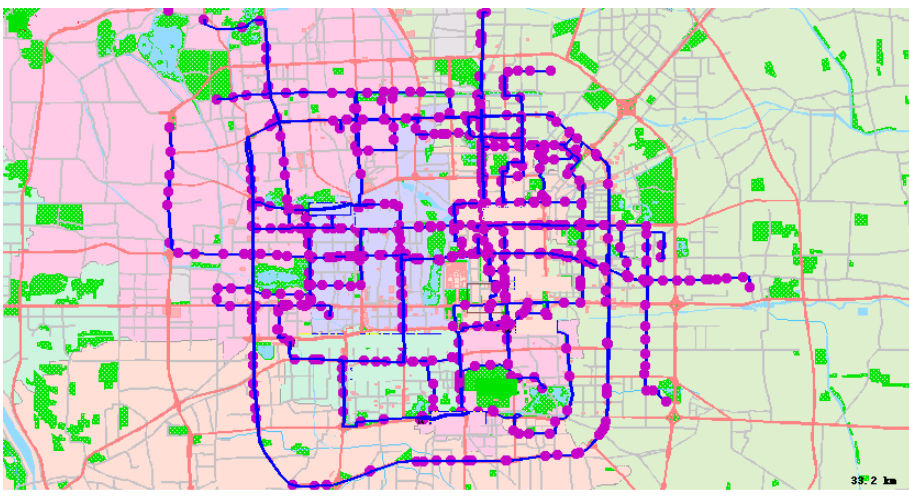
Fig.2 (a) Subsystem of 30 transport line of Beijing urban transit network in